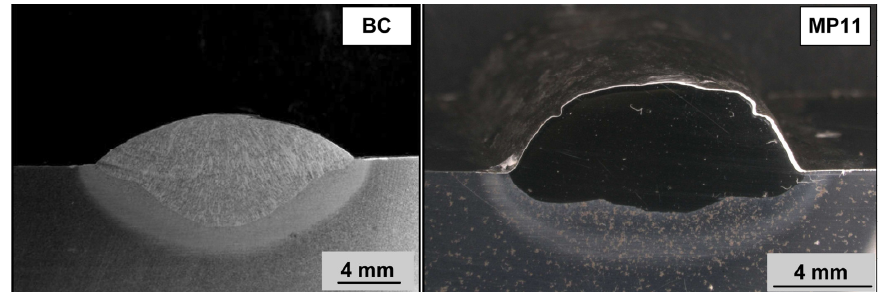
Figure 1. Photograph of BC and MP11 weld metal